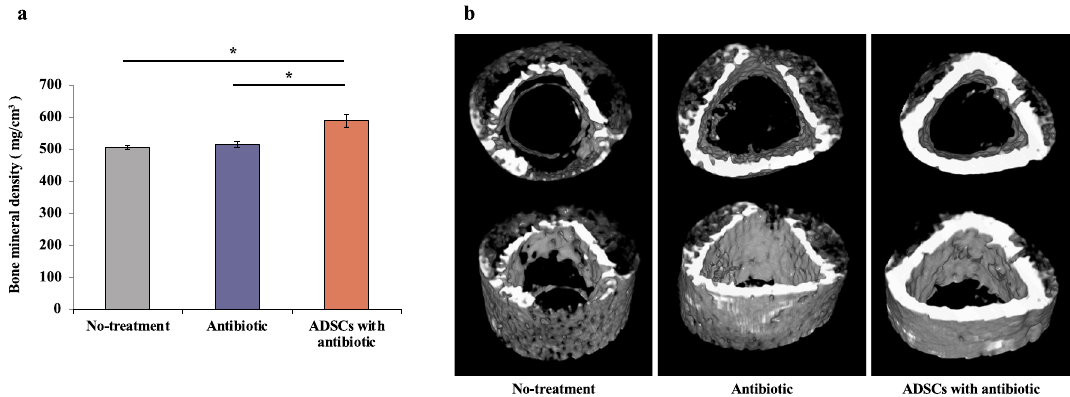
Figure 4. Evaluation of μCT. ( a ) Quantification of the femoral bone mineral density of each femur in the three groups 14 days after insertion of the K-wire. ( b ) Three ‐ dimensional μCT axial images of the distal femoral region 14 days after insertion of the K-wire. All statistical analyses were performed using Welch ANOVA followed by Tukey HSD post-test (n = 6 rats per group). The error bars are defined as standard error of the mean. *p < 0.05. ADSC adipose-derived mesenchymal stem